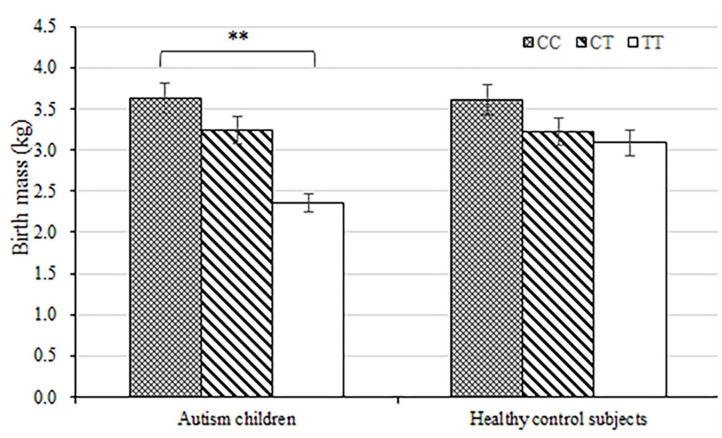
Load-dependent effects of MTHFR C677 genotypes on the birth body mass (kg) in autism children but not in healthy control subjects. Error bars ± 1.00 standard error. **P < 0.01.